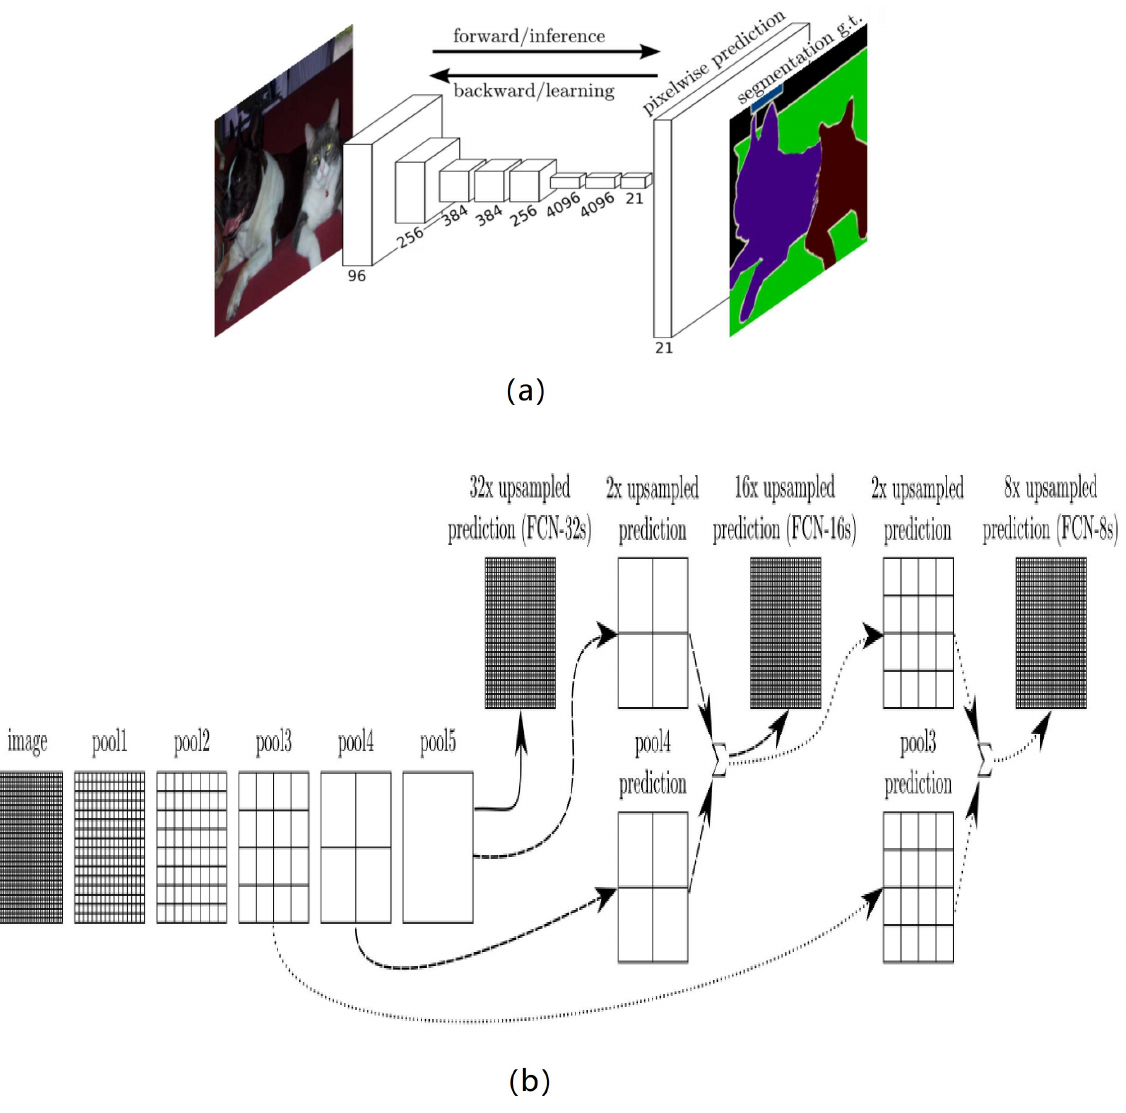
Figure 1. ( a ) FCN model with VGG as a backbone [9]. ( b ) Skip layer of FCN: There are three versions of the FCN network, namely FCN-8S, FCN-16S, and FCN-32S. The 32S version directly performs image restoration after a feature fusion, so the output quality is the lowest, but the number of parameters is the lowest. The 8S version can obtain the highest precision output after three times of feature fusion. 16S is relatively